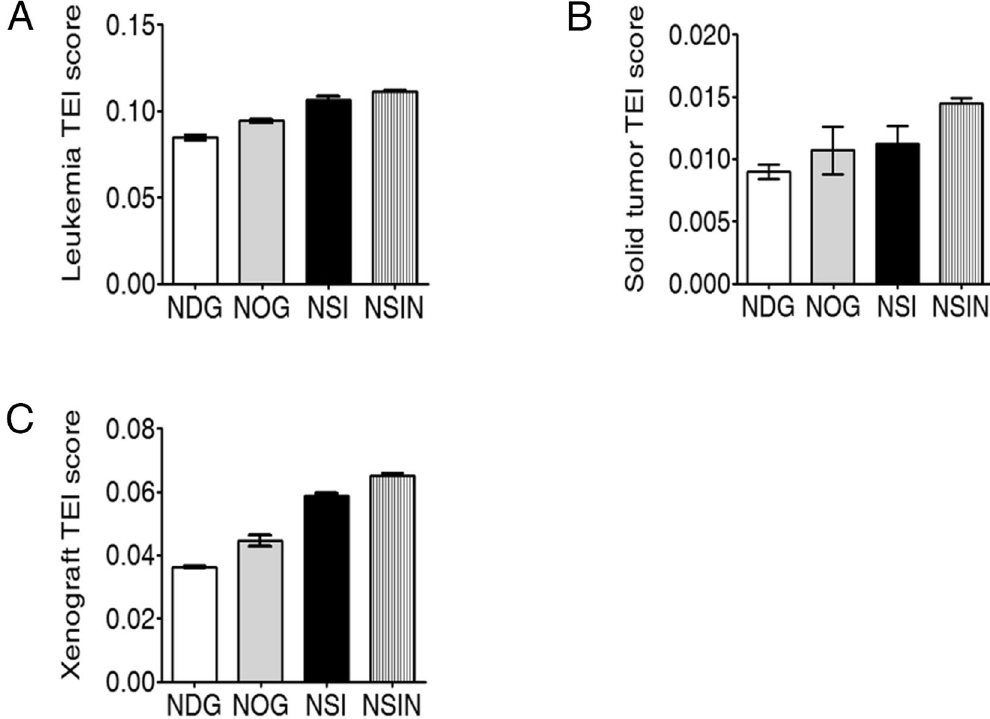
Figure 6. NSIN mice show higher tumor engraftment index (TEI) scores than NDG, NOG, and NSI mice. ( A ) TEI scores of NDG, NOG, NSI, and NSIN mice for Nalm6 cells. ( B ) TEI scores of NDG, NOG, NSI, and NSIN mice for A549 cells. ( C ) Overall TEI scores of NDG, NOG, NSI, and NSIN mice for both leukemia and solid tumors. Xenograft TEI scores as indicators of